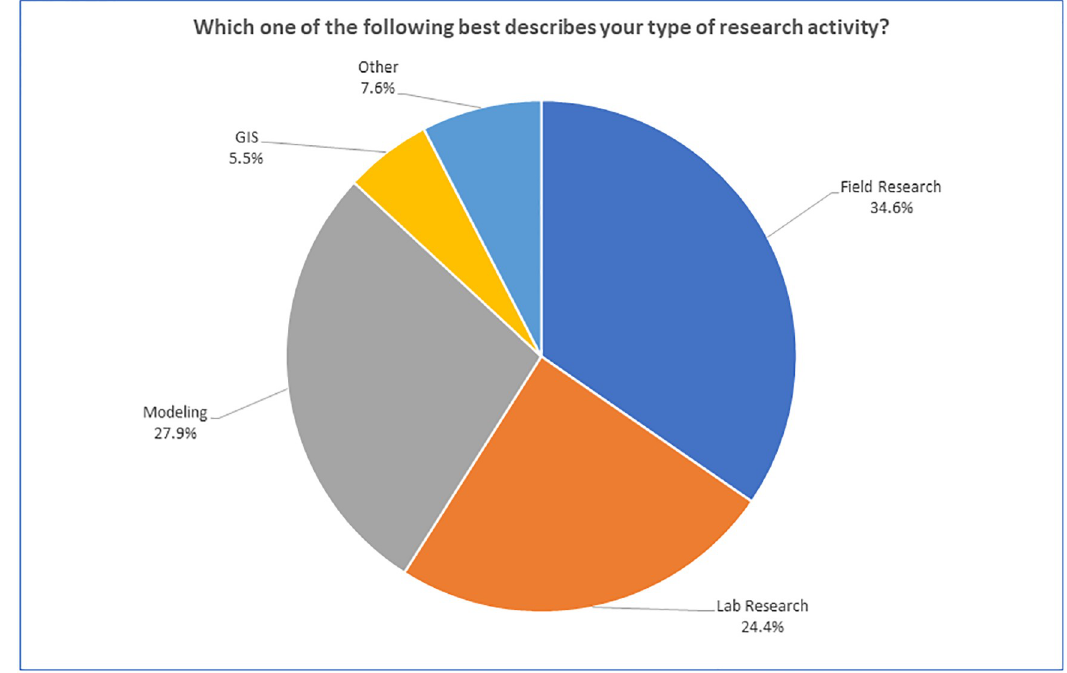
Fig 3. “Which of the following best describes your primary type of research activity?” (n = 2032).